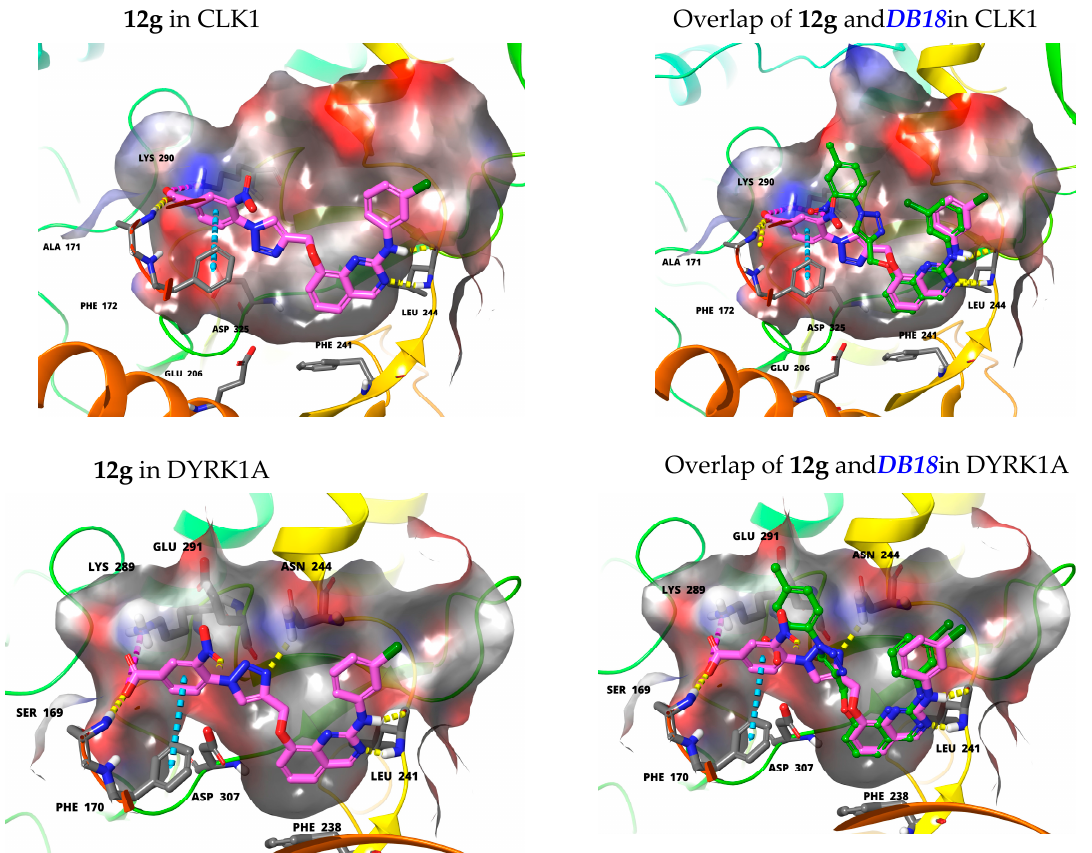
Figure 3. ( a ) 12g in CLK1 cavity; ( b ) overlap of 12g with DB18 in CLK1 active site; ( c ) 12g in DYRK1A cavity; ( d ) overlap of 12g with DB18 in DYRK1A active site. The ligands DB18 and 12g are shown as thick residues in color-faded magenta and DB18 is highlighted in green ball-and-stick models. Color coding: oxygen-red, nitrogen-blue, carbon-grey in case of protein. Background covers the rest of the protein chain in ribbon model and all the images were prepared using Maestro 13.1. Backbone, side-chain hydrogen bonds are shown as yellow-dotted lines, π - π stackings are given in light blue-dotted lines whereas, charged interactions are provided in pink-dotted lines. To focus the interactions of active site residues with ligands 6.0, Å surface area of protein has been shown in the figures.